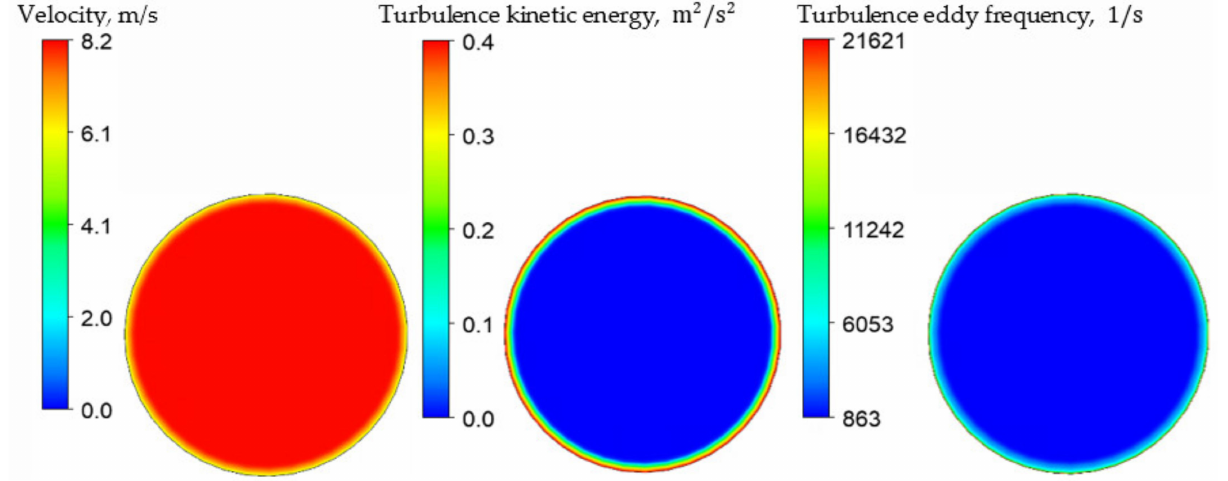
Figure 4. A typical profile set used as an inlet